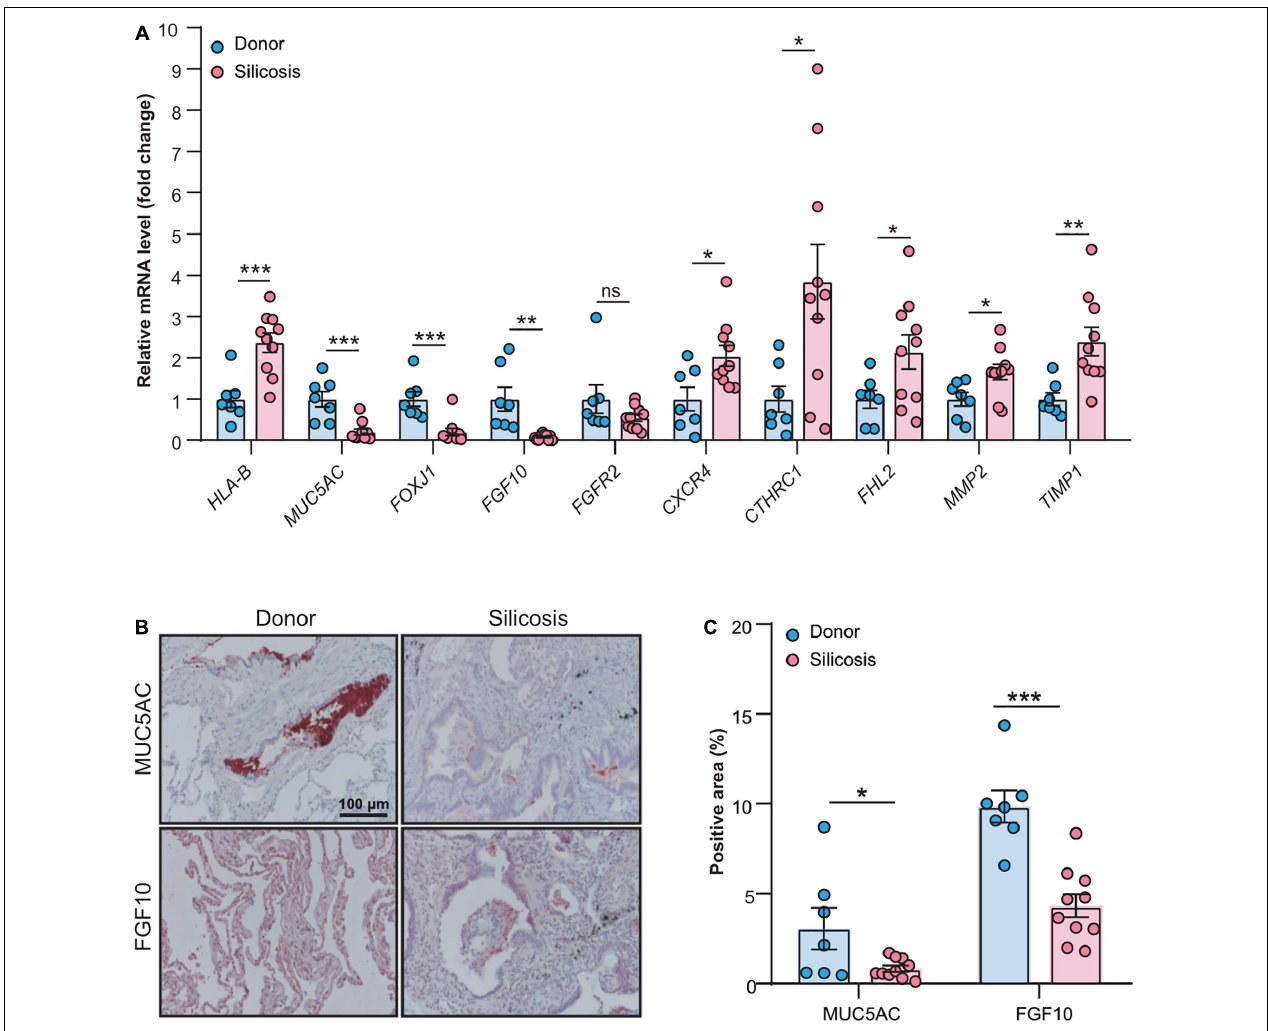
FIGURE 7 | Validation of key genes revealing by RNA-seq through experimental approaches. (A) Relative mRNA expression levels of the genes ( HLA-B , MUC5AC , FOXJ1 , FGF10 , FGFR2 , CXCR4 , CTHRC1 , FHL2 , MMP2 , and TIMP1 ) in the lung tissues from silicosis patients ( n = 10) or non-diseased donors ( n = 7). (B) Representative images of immunohistochemical staining of MUC5AC and FGF10 in the lung tissues from silicosis patients or non-diseased donors. Red color indicates the positive staining. All scale bars are 100 µ m. (C) Quantified immunoreactivity of MUC5AC and FGF10 in lung sections from silicosis patients ( n = 10) or non-diseased donors ( n = 7). All the quantitative results are presented as mean ± SEM. The differences were analyzed by two-tailed Student’s t -test. ns, no significance, * P < 0.05, ** P < 0.01, *** P < 0.001.